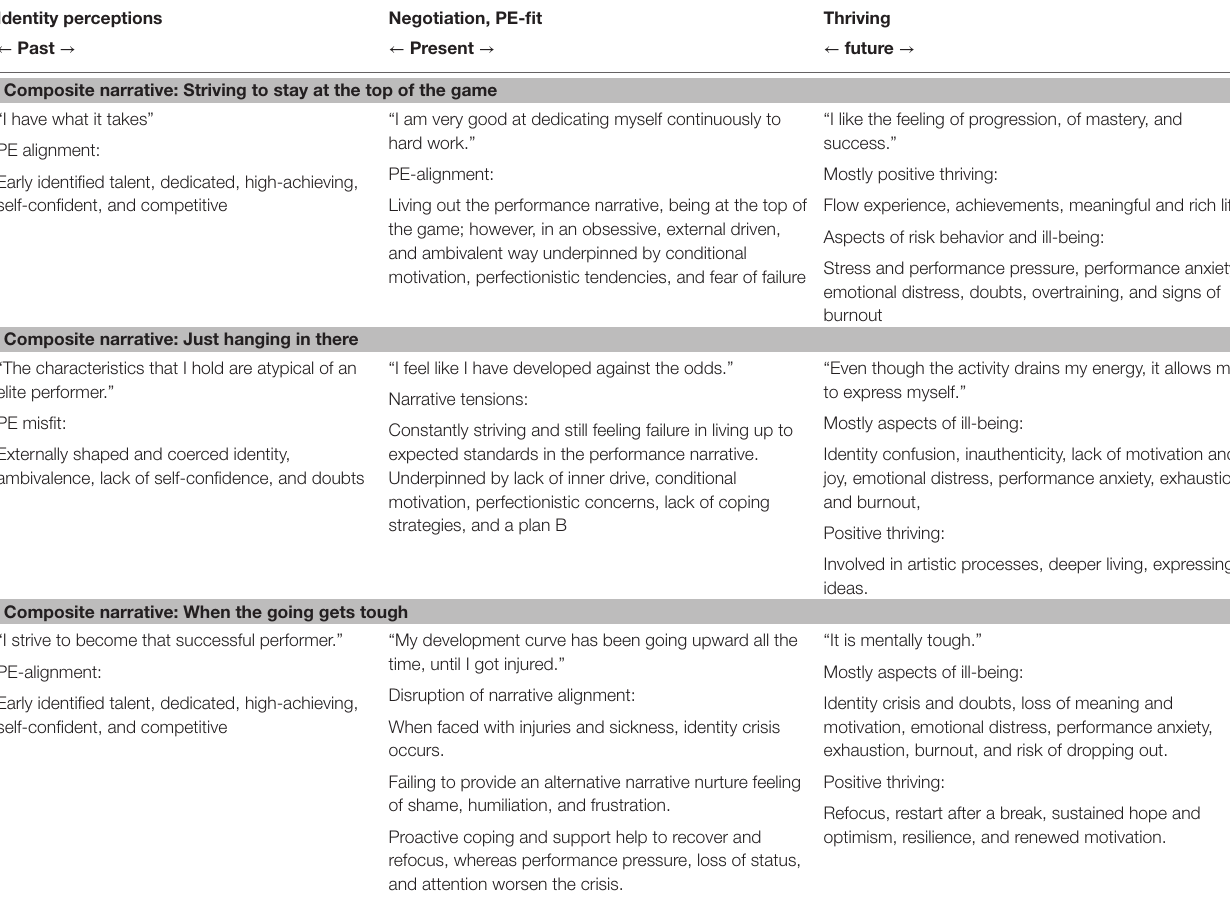
TABLE 1 | Overview of the three composite narratives. Identity perceptions Negotiation,